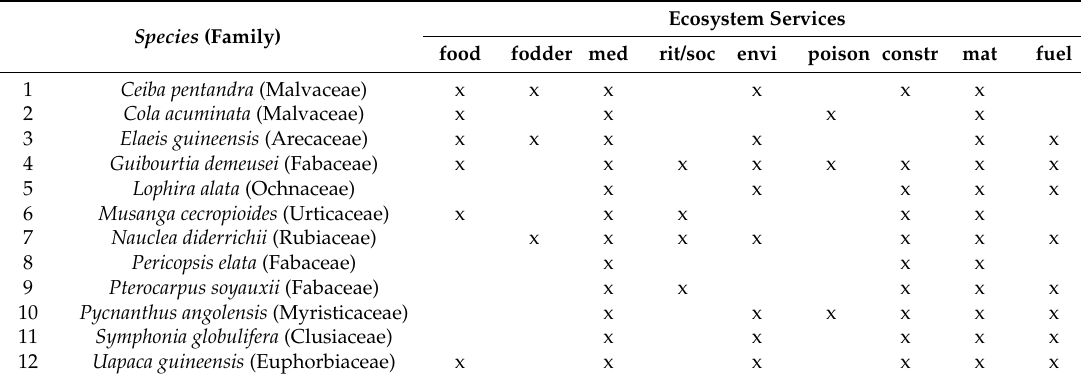
Table 1. The selected species and the ecosystem services they provide as reported by the BIOSERF (Sustainability of tropical forest biodiversity and services under climate and human pressure) project [54] supplemented with data from the PROTA (Plant Resources of Tropical Africa) database (www.prota4u.org). The services are food, fodder, medicinal uses (med), ritual or social uses (rit/soc), environmental uses (envi), poison, construction (constr), materials (mat) and fuel. Ecosystem Services Species (Family) food fodder med rit/soc